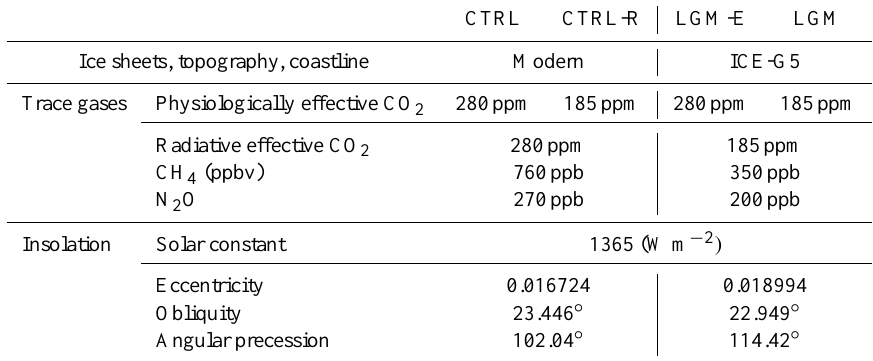
Table 1. Boundary conditions and forcing used in the simulations referred to as CTRL, CTRL-R, LGM-E, LGM in this study. Ice sheet, topography and coastline are taken from Peltier (2004), orbital parameters from Berger (1978). These conditions are chosen according to the PMIP-2 protocol (Braconnot et al., 2007). CTRL CTRL-R LGM-E LGM Ice sheets, topography, coastline Modern ICE-G5 Trace